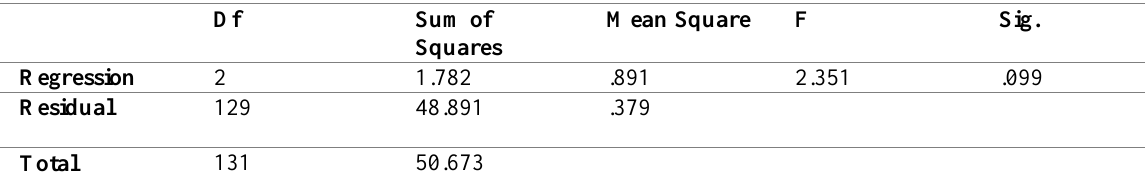
Table 5 . Results of Regression of Low TV Viewers Achievement Motivation on the Independent Variables Df Sum of Mean Square F Sig. Squares Regression 2 1.782 .891 .099 Residual 129 48.891 .379 Total 131 50.673